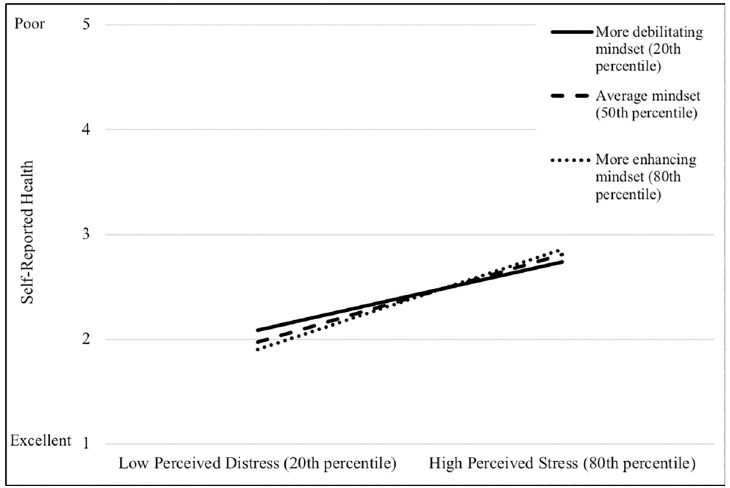
Fig 2. Graphical representation of interaction between perceived distress and general stress mindset predicting general self-reported